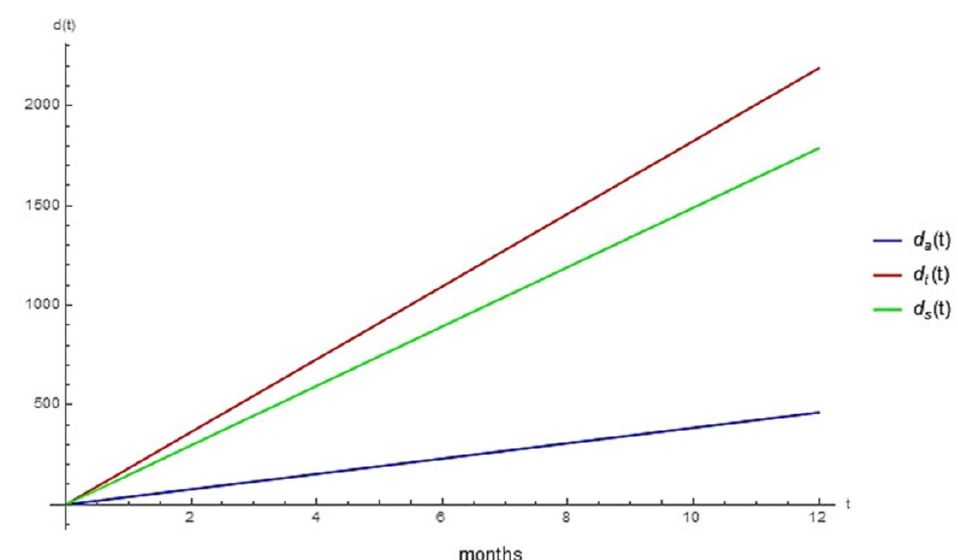
Figure 7. Corrosion depth expressed as a linear function of